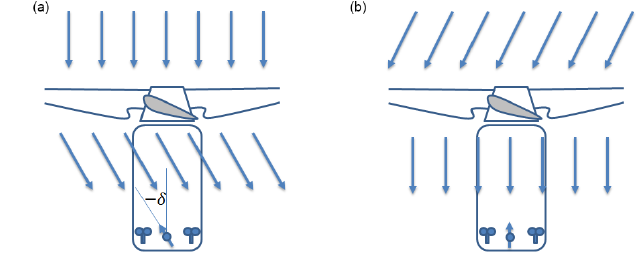
Figure 2. Illustration of the simplified flow in front of and behind the rotor. (a) The blade forces the flow to twist and an optimal aligned turbine obtains a flow deflection angle δ , which needs to be considered in the turbine alignment. (b) A turbine with the wind vane aligned to the rotor axis faces the wind at a certain yaw